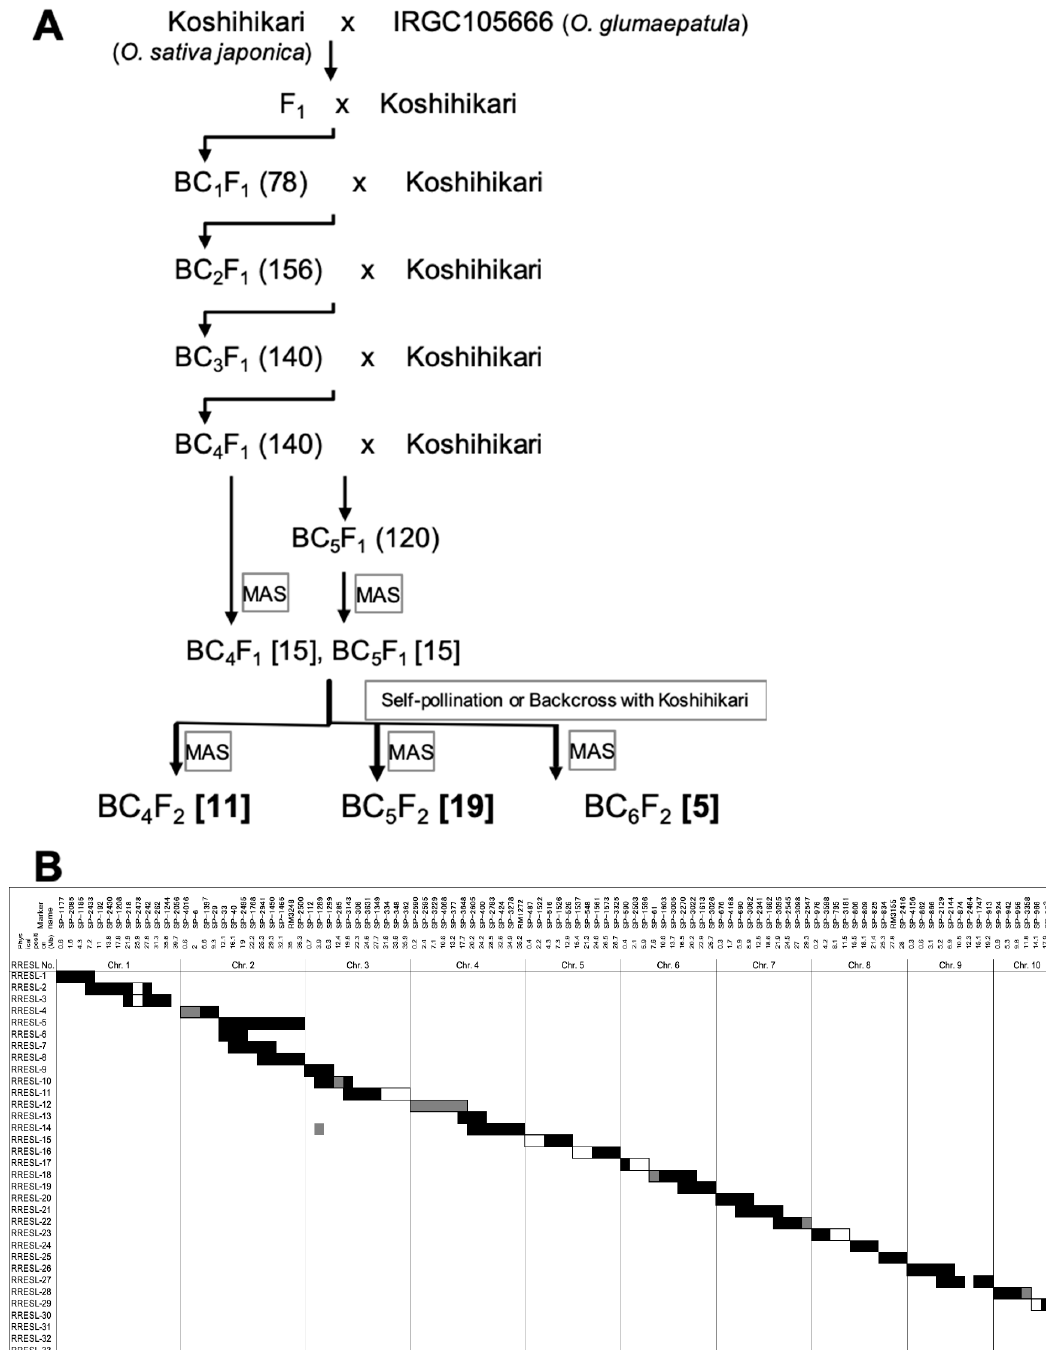
Figure 1. Flowchart of the development of RRESL. ( A ) Breeding scheme for developing RRESL carrying IRGC105666 ( O . glumaepatula ) chromosome segments in the Koshihikari ( O . sativa ssp. japonica ) genetic background. Numbers in round and square brackets indicate the numbers of lines produced in each backcross generation and candidate lines for RRESL selected by marker-assisted selection (MAS), respectively. Bold numbers in brackets were finally selected from the resulting chromosome segment substitution lines (CSSL). ( B ) Graphical representation of the genotypes of the 35 lines in RRESL. White and black bars indicate homozygous chromosomal segments derived from Koshihikari and IRGC105666, respectively. Gray bars represent heterozygous regions. Single nucleotide polymorphism (SNP) markers used for MAS are indicated above the table with their physical positions (Mb) for each chromosome (see also Supplementary Table